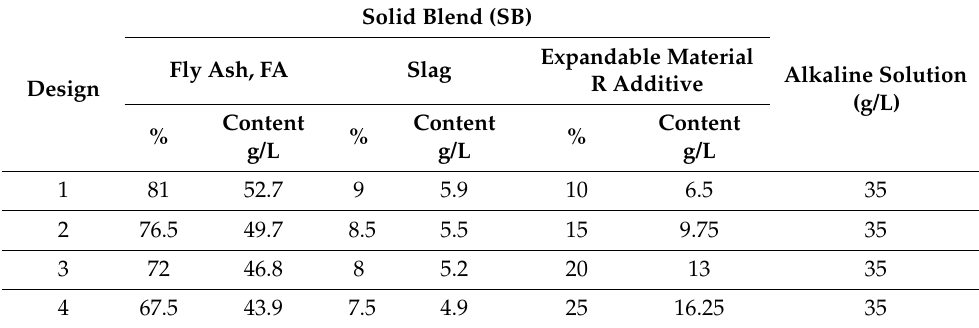
Table 2. Details of geopolymer trial mixture